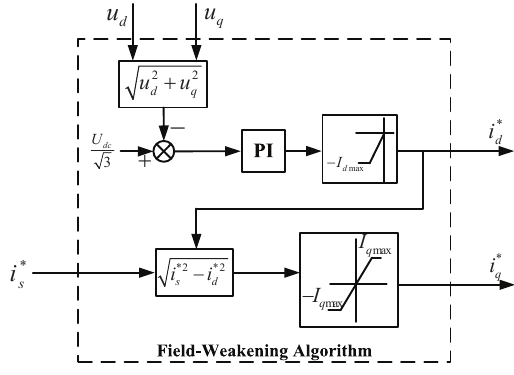
Figure 2. Voltage-comparison based flux-weakening